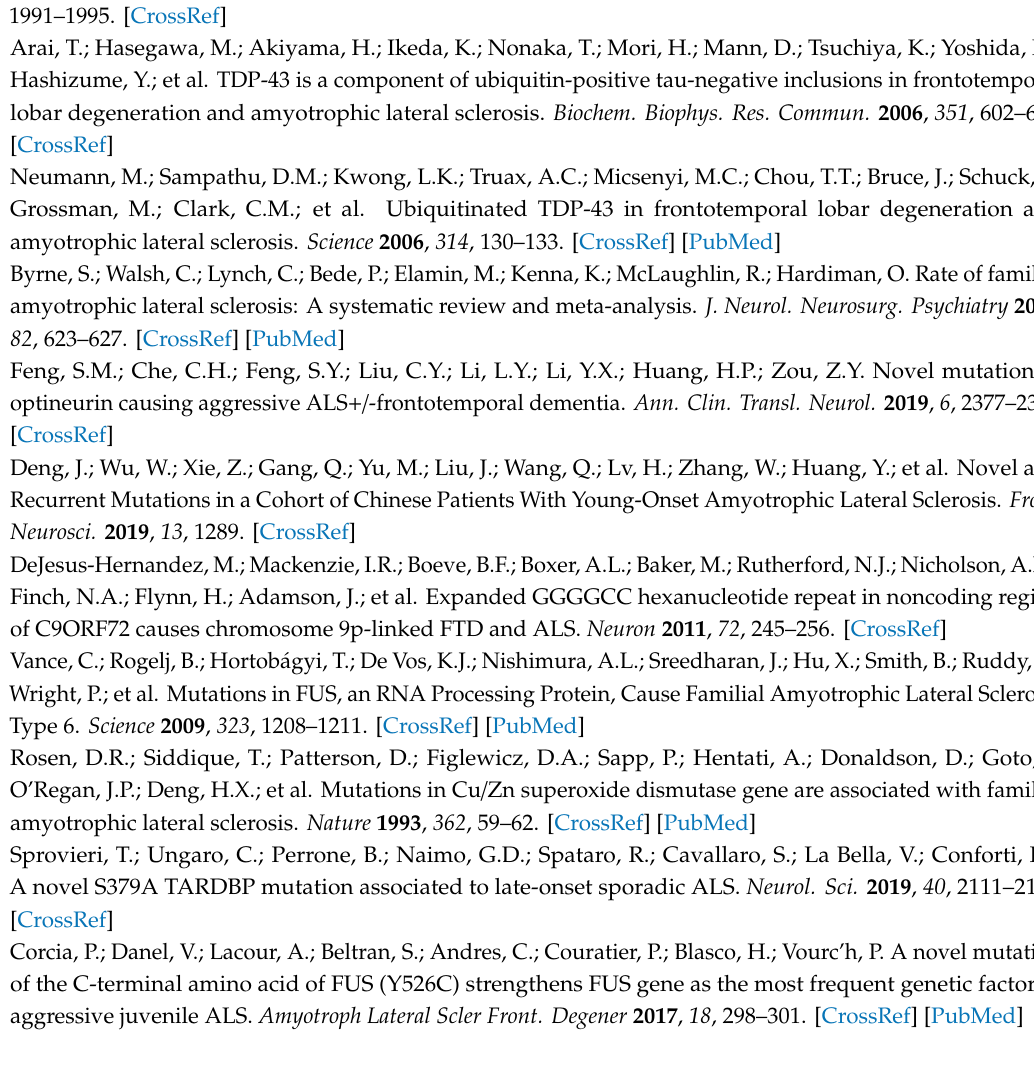
Supplementary Table S1: LFQ values of heat map displaying clustering of TB and MCEV proteins. MaxLFQ was used for analysis [46]; Supplementary Table S2: Statistically significant di ff erentially expressed proteins in ALS MCEVs compared to NC